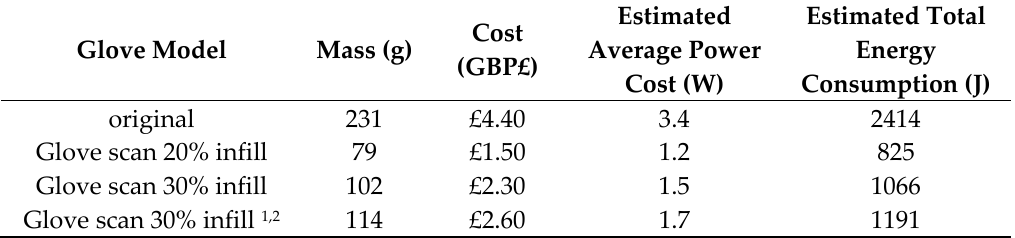
Estimated Estimated Total Cost Average Power Energy (GBP£) Cost (W) Consumption (J)